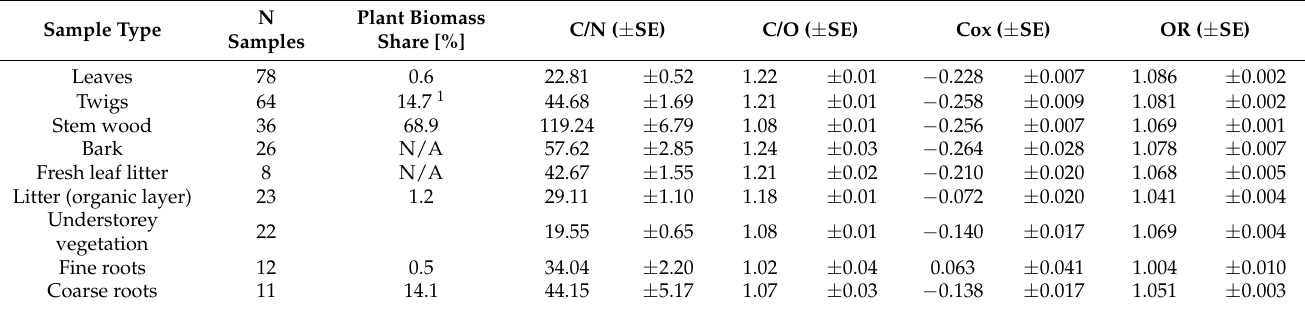
Table 3. C/N, C/O, C ox , and OR of the ecosystem components independent of time (mean with standard error SE). Fresh leaf litter are leaves collected from the ground in October, still green in color, while litter is the deposited organic material (leaves, twigs, seeds) on the forest floor. Fine roots and coarse roots are not specifically from the beeches, but a mix of unidentified species. 1 The biomass data are for branches and twigs [25], while the collected samples are twigs. The biomass share of only twigs is not known. Stem wood includes 6 samples from May and October 2019, as well as from the 2020 stem core